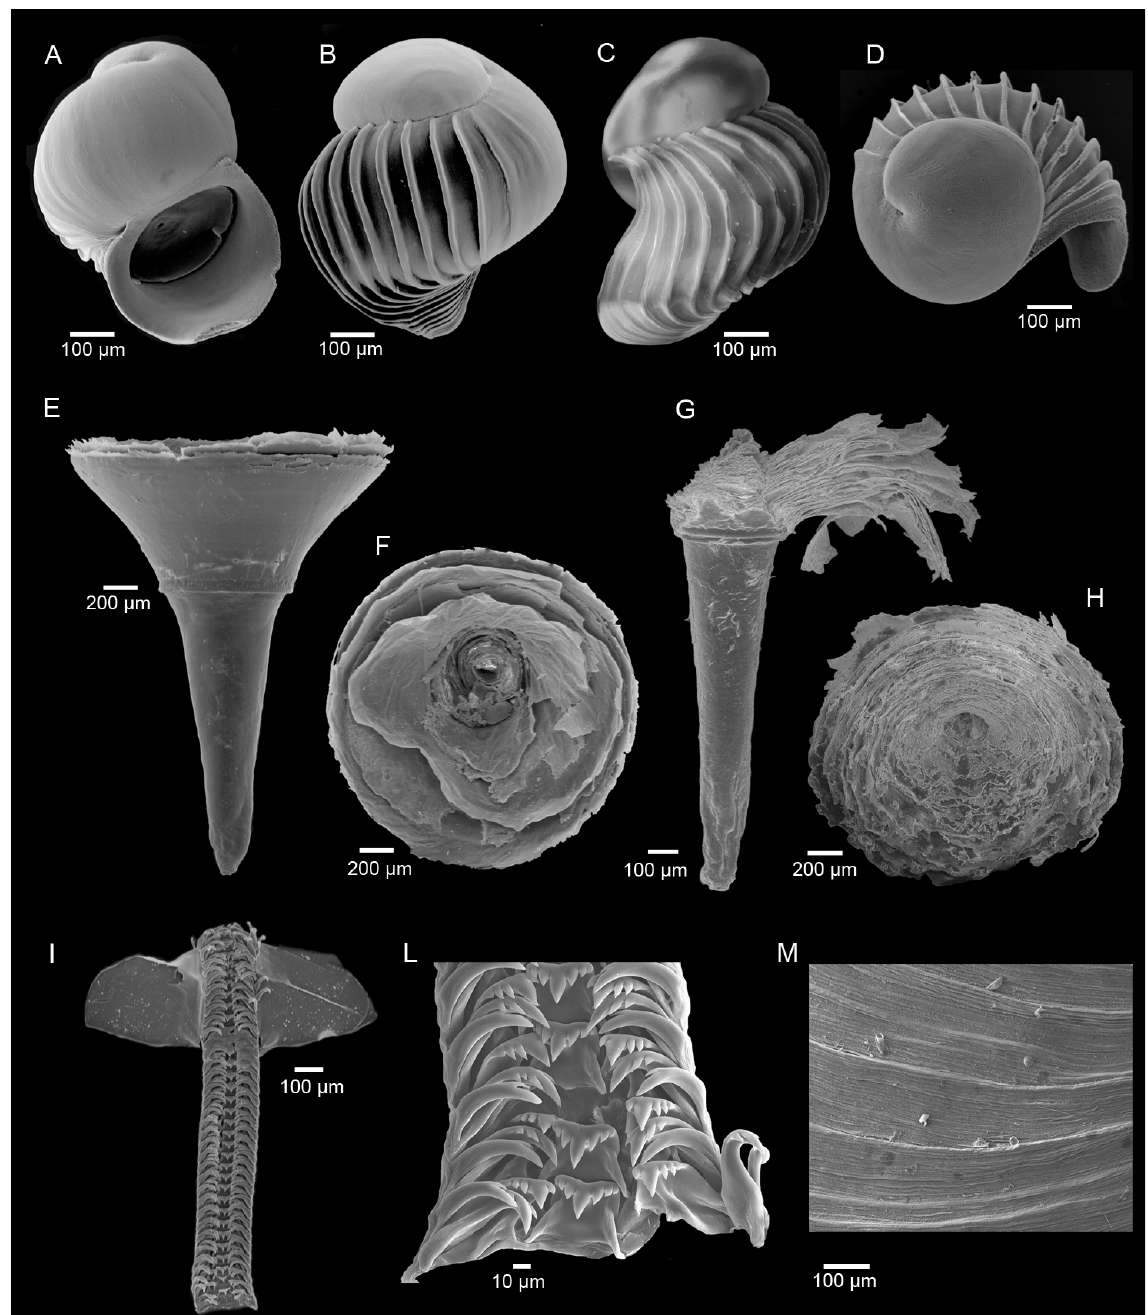
Fig. 2. Novastoa rapaitiensis sp. nov. A–D . Pre-hatching larval shells from egg mass of Fig. 1M. E–F . Operculum of specimen from Rapa Iti (not from the type series). G . SEM image of lateral view of operculum, with lamina stripped away to expose underlying structure (MNHN IM-2000-31684, Rapa Iti Island, French Polynesia). H . SEM image of exterior surface of operculum (MNHN IM-2000-31684, Rapa Iti Island, French Polynesia). I . Radula of specimen from Rapa Iti. L . Central section of radula (MNHN IM-2000-31684, Rapa Iti Island, French Polynesia). M . SEM image of teleoconch sculpture after removal of surrounding substrate (UF 436684, Moorea Island, French